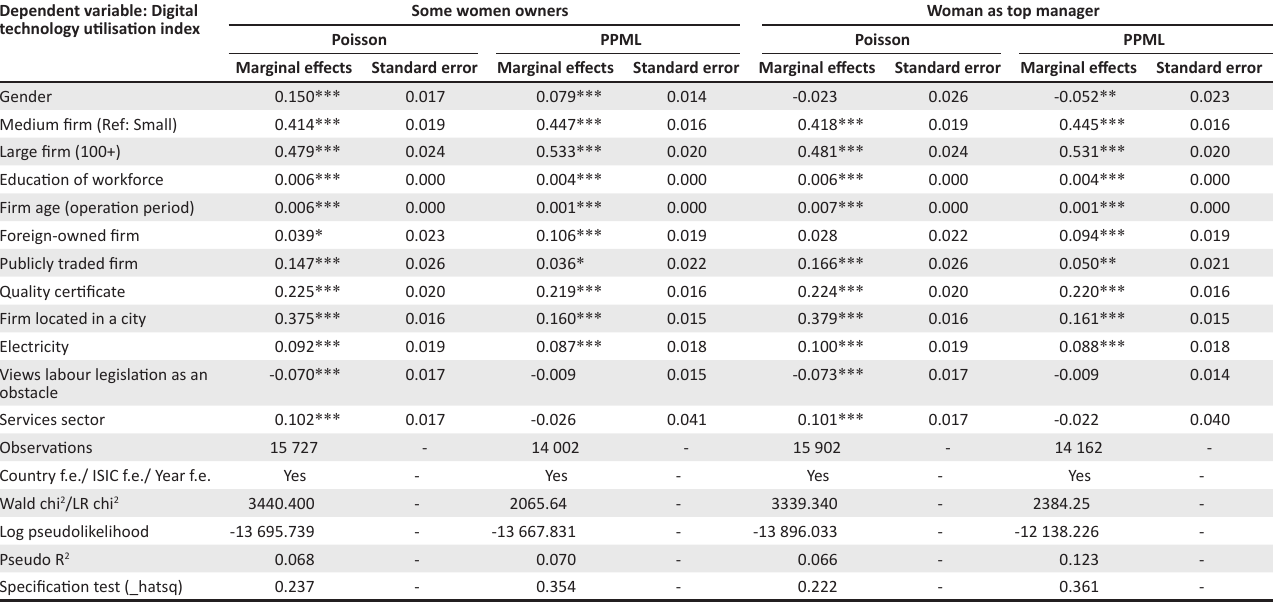
TABLE 4: Poisson estimates of the intensity of digital technology utilisation. Dependent variable: Digital technology utilisation